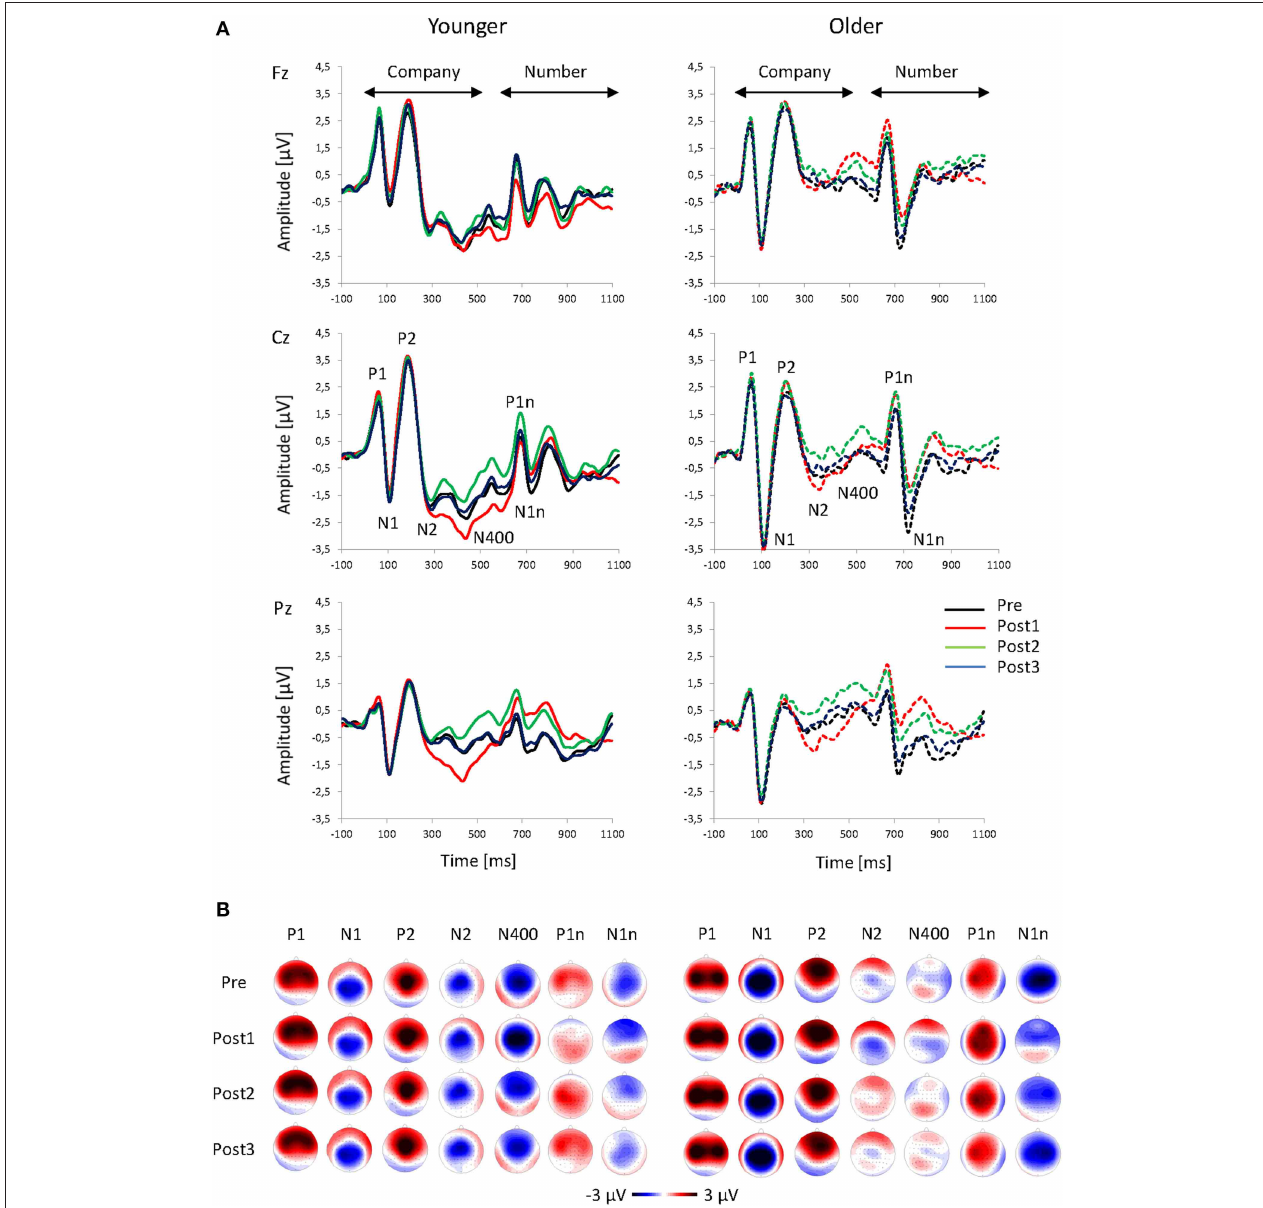
FIGURE 3 | Grand-average ERPs. (A) ERPs at Fz, Cz, and Pz plotted as a function of time relative to the speech onset and (B) topographies of the ERP components to the onset of the company name (P1, N1, P2, N2, and N400) and value (P1n and N1n) for Pre, Post1, Post2, and Post3 sequences, and for younger and older